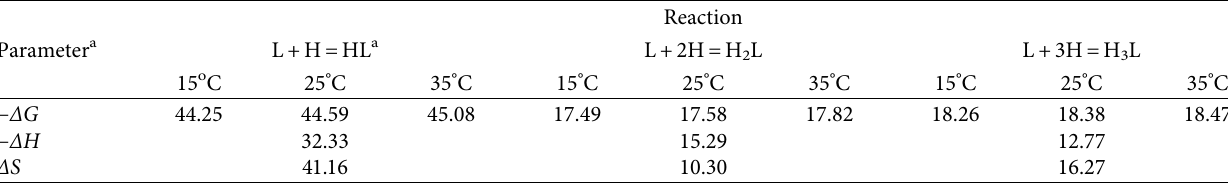
2 O (V/V) solution.